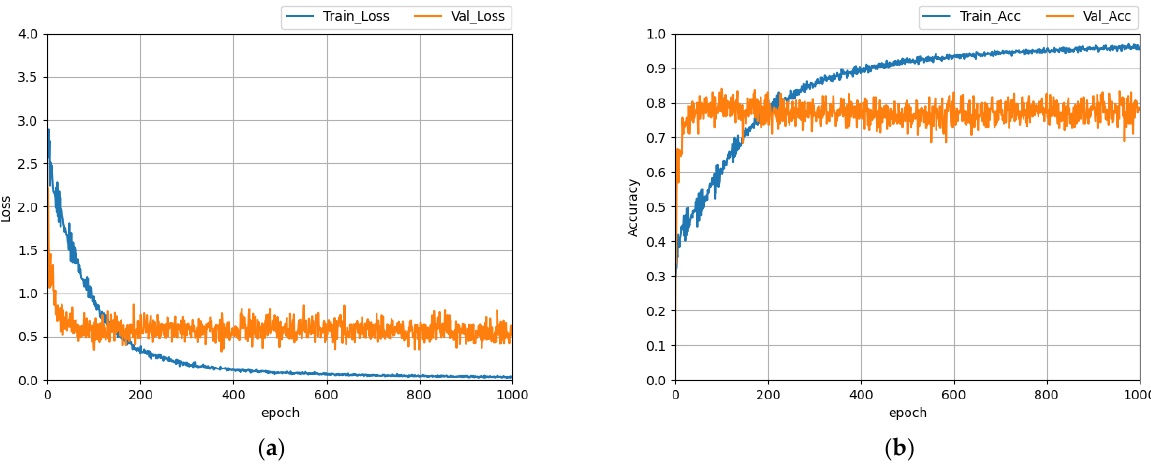
Figure A3. Training result for the ArcFace learning method. ( a ) loss; ( b ) accuracy. The model was trained using the proposed learning method combined with the triplet loss and the ArcFace, respectively. First, the proposed model was trained with the triplet loss in stage 1. Figure A4 illustrates the training results.